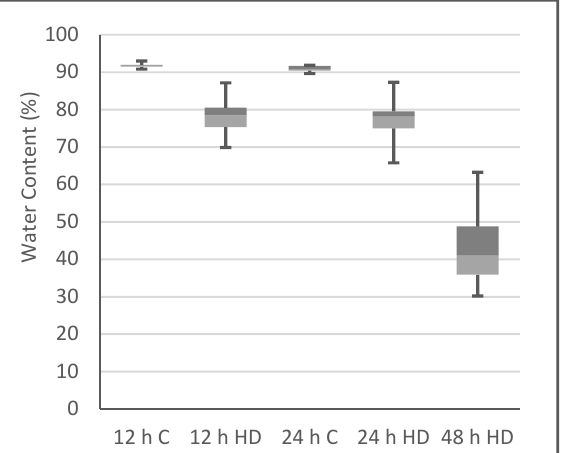
Figure 2. Boxplots of the average percentage of water content ((FW − DW)/FW) × 100) of control (C) and heat/drought treated plants (HD) at 12, 24, and 48 h time points. FW, fresh weight; DW, dry weight.